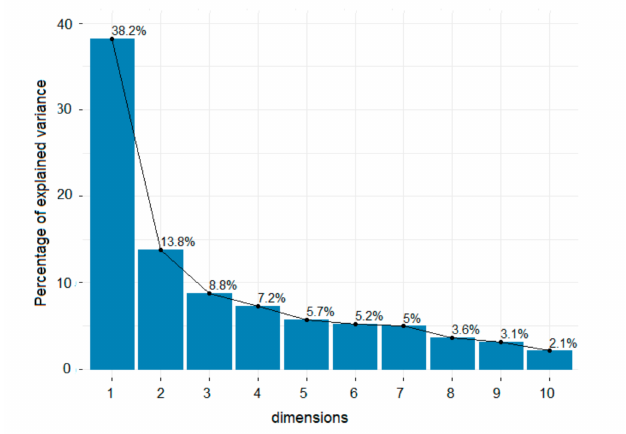
Figure 6. Scree plot.